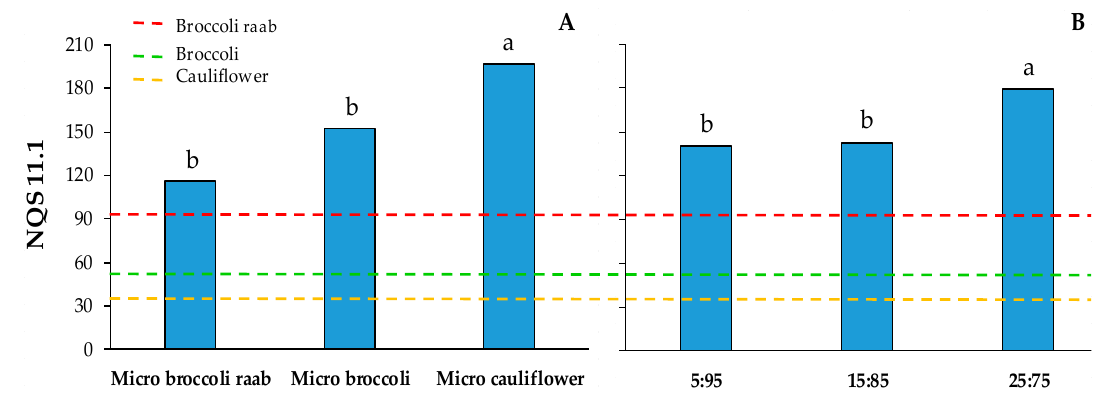
Figure 4. Main effects of genotype (micro broccoli raab, micro broccoli and micro cauliflower—( A )) and NH 4 :NO 3 molar ratio of the nutrient solution (5:95, 15:85, and 25:75—( B )) on Nutrient Quality Score (NQS) 11.1 of Brassica microgreens. Significance: p ≤ 0.05 ( A ); p ≤ 0.05 ( B ). For each main effect, different letters indicate that mean values are significantly different ( p = 0.05). The horizontal lines indicate the NQS 11.1 of mature broccoli raab, broccoli and cauliflower.